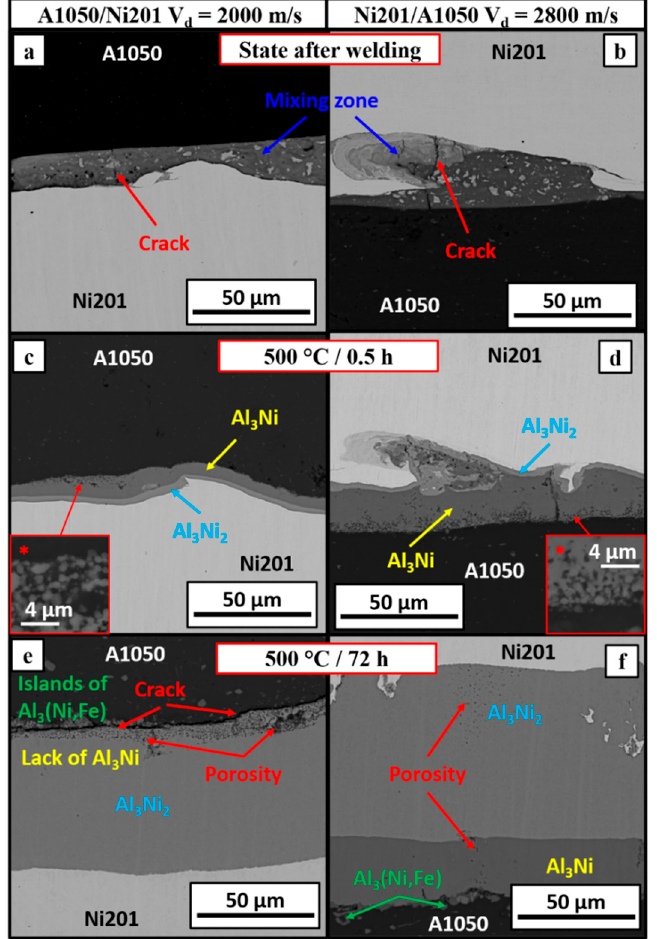
Figure 8. Comparison of the microstructure of the interface zone in A1050/Ni201 and Ni201/A1050 clads in the state after explosive welding ( a , b ) and after annealing at 500 °C for 0.5 h ( c , d ) and 72 h ( e , f ). The clads were manufactured at 2000 m/s ( a , c , e ) and 2800 m/s ( b , d , f ) detonation velocity.